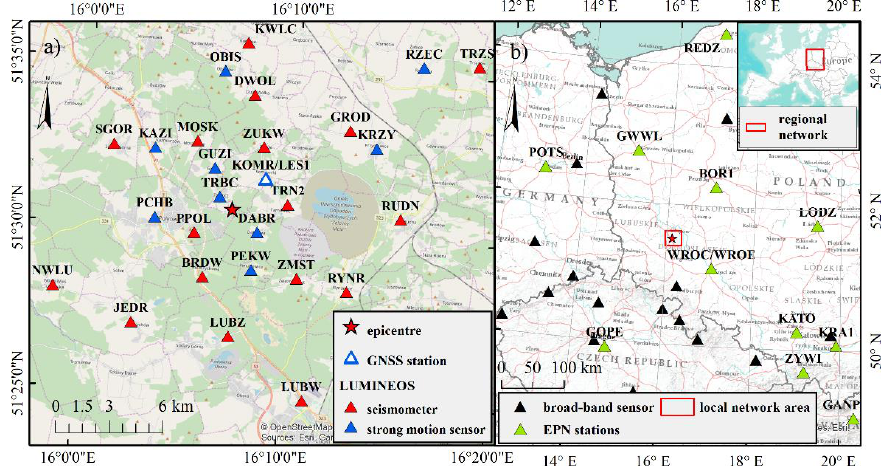
Figure 1. The seismic networks employed: ( a ) Local LUMINEOS network—strong motion sensors (blue triangles), seismometers (red triangles) and location of the KOMR GNSS station, LES1, aligned with a strong motion sensor. The epicentre is marked by a red star. ( b ) Regional network of broad-band sensors (black triangles) used to estimate the source mechanism, the closest EPN GNSS stations and the WROE reference station (green triangles). Location of these networks within Europe (inset).